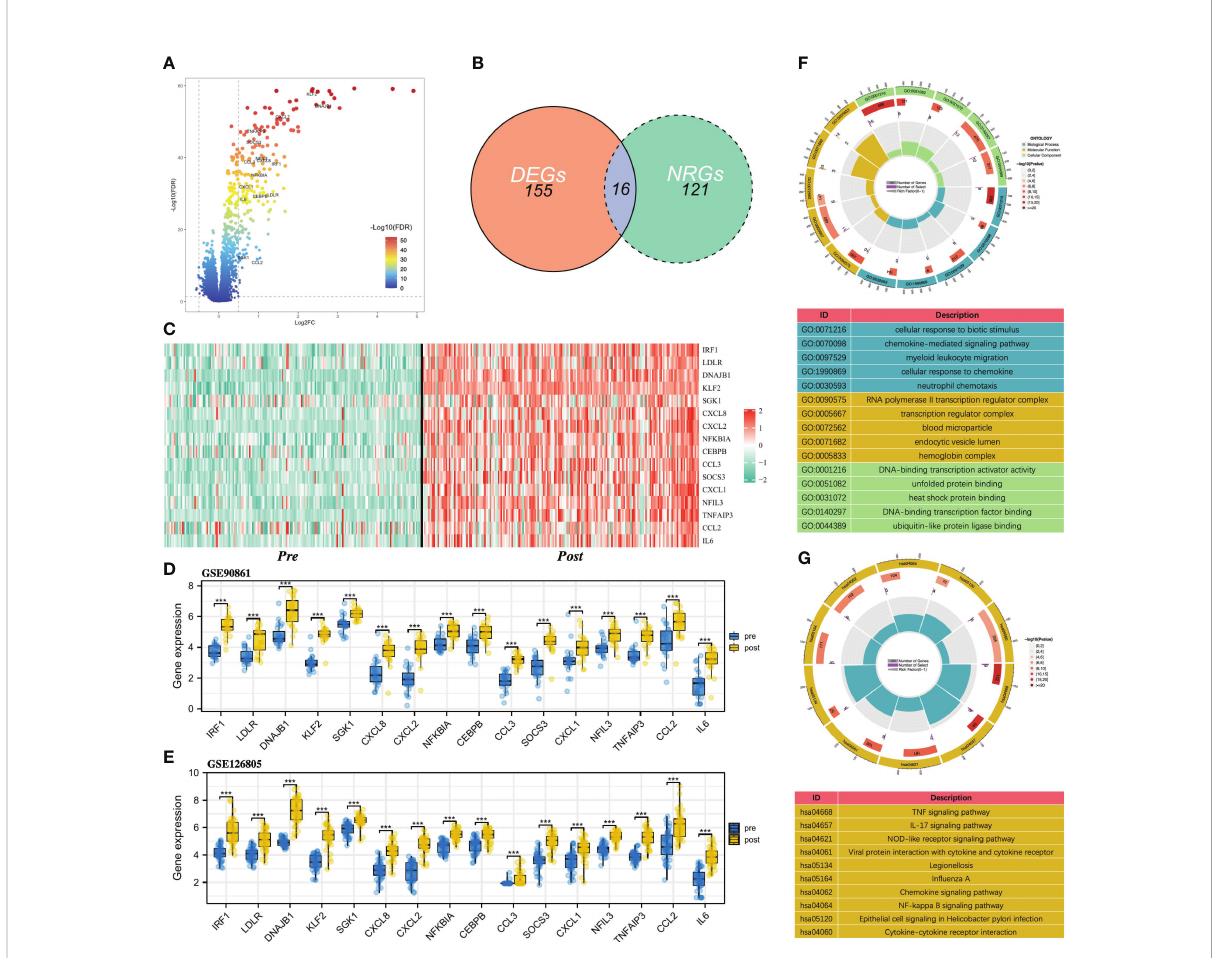
FIGURE 2 Identi fi cation of DE-NRGs and functional enrichment analysis. (A) Volcano plot of DEGs, and the gene symbols of DE-NRGs were labeled. (B) Intersection between DEGs and NRGs in renal IRI. (C) Heatmap of the expression of 16 DE-NRGs in control samples and IRI samples. (D, E) Box and scatter plots showing the expression of 16 upregulated DE-NRGs in GSE90861 and GSE126805. (F) GO enrichment analysis of DE-NRGs in terms of biological process, cellular component, and molecular function. (G) KEGG pathway analysis of DE-NRGs. NRGs, NET-related genes; DEGs, differentially expressed genes; DE-NRGs, differentially expressed NRGs; IRI, ischemia reperfusion injury; GO, Gene Ontology; KEGG, Kyoto Encyclopedia of Genes and Genomes. ***P <